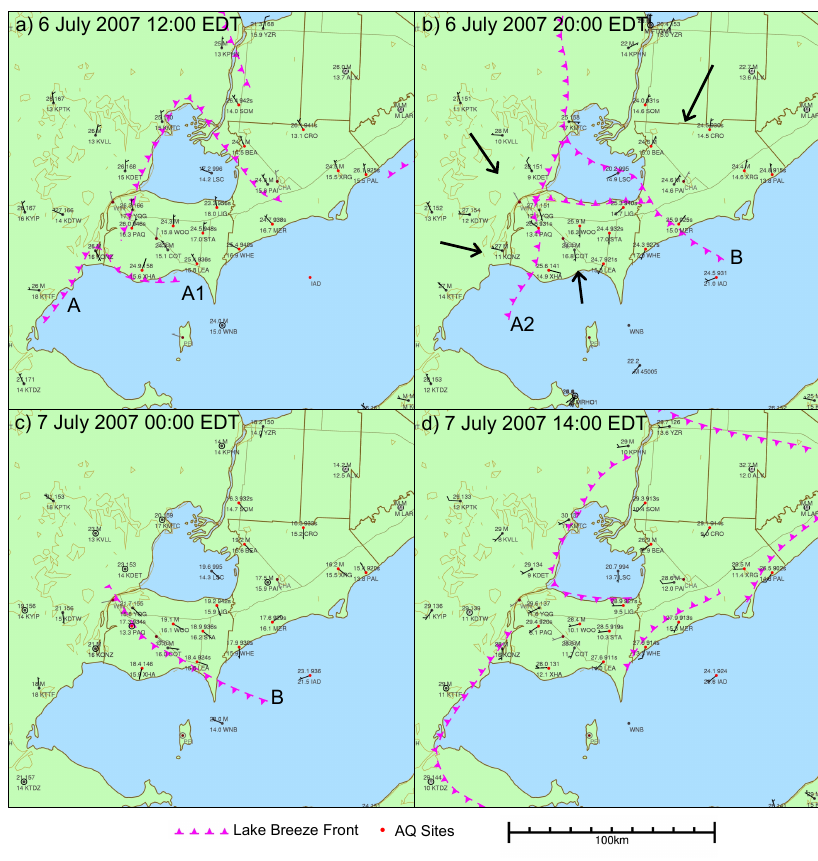
Fig. 5. Breeze-front locations on 6 July at (a) 12:00EDT and (b) 20:00EDT, and 7 July at (c) 00:00EDT and (d)